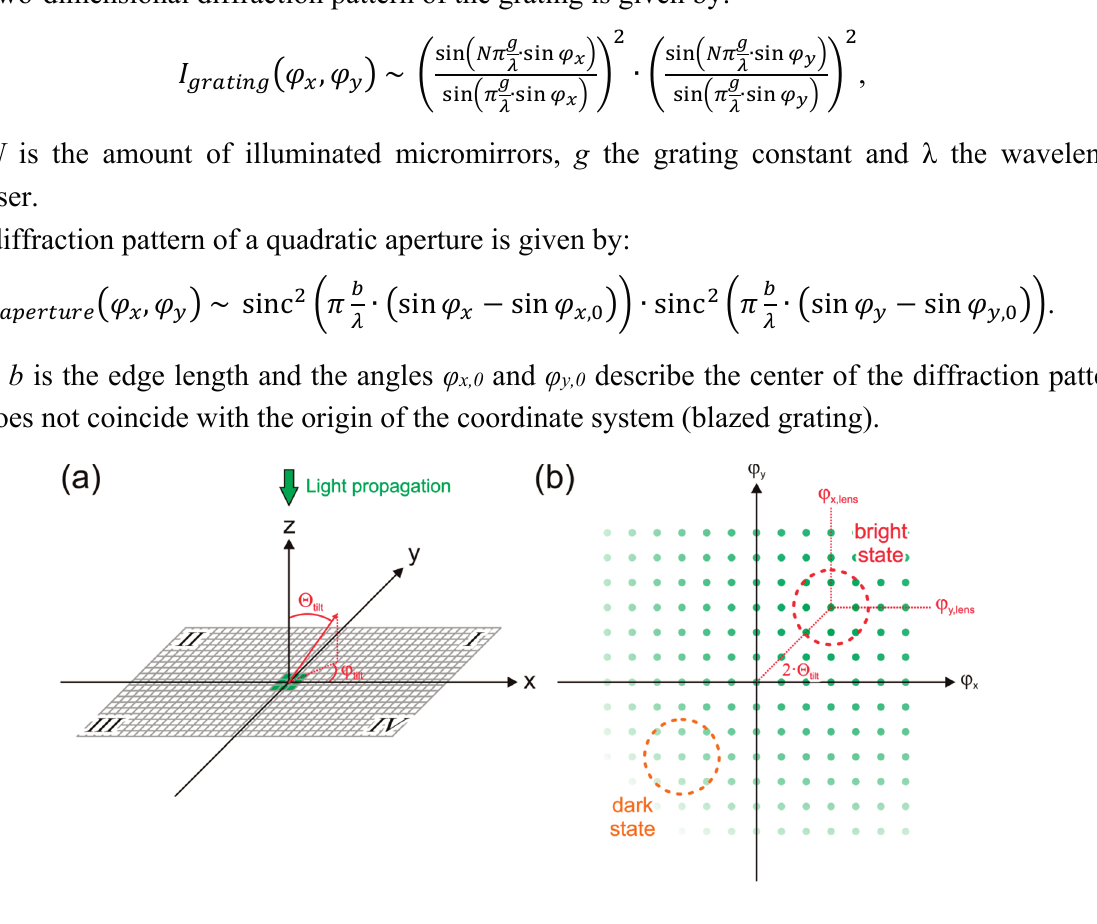
Figure 6. Diffraction of monochromatic light at the DMD. ( a ) The DMD shall be located in the x/y plane of a Cartesian coordinate system. Light propagates along the z -axis and illuminates a small area of the DMD (here: 3 × 3 micromirrors, marked in green). The red vector gives the tilting of the micromirrors. ( b ) Scheme of the diffraction pattern in angle space. The diffraction orders gathered by lens L2 (see Figure 1) in the “bright state” and in the “dark state” are marked by red and orange areas,